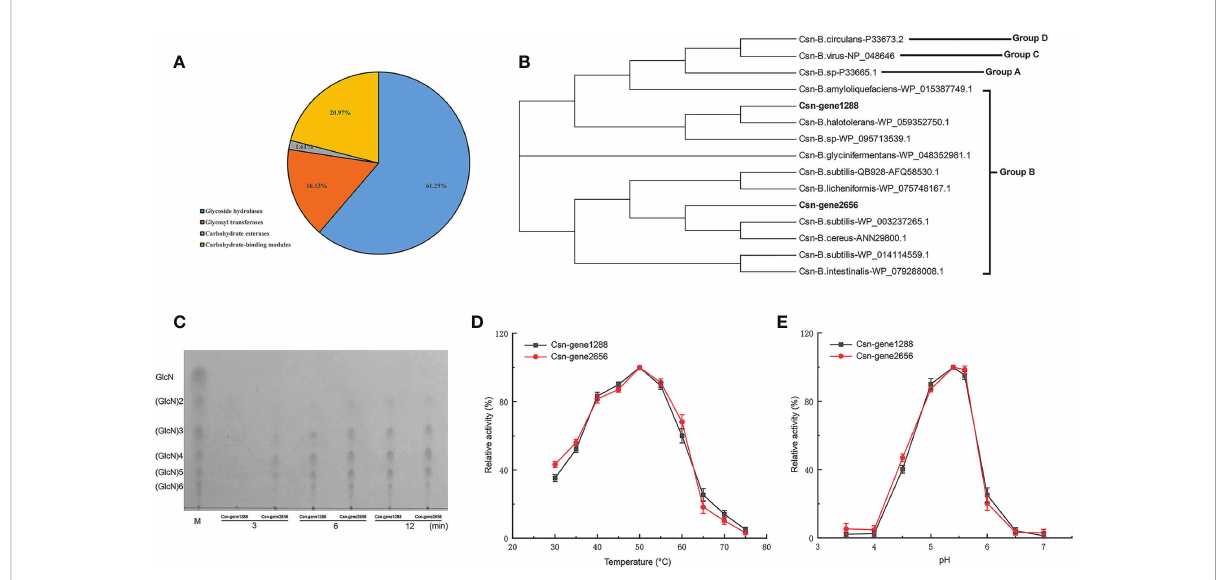
FIGURE 6 Carbohydrate-active enzyme activity analysis of the two chitosanase csn-gene1288 and csn-gene2656. (A) Statistical chart of annotated carbohydrate-active enzyme in B halotolerans LDFZ001. (B) Sequence alignment of csn-gene1288 and csn-gene2656 with that of other GH46 chitosanases. (C) Time course pro fi les of hydrolysis products of csn-gene1288 and csn-gene2656 enzymes on chitosan. (D) Effects of temperature on the enzyme activities of csn-gene1288 and csn-gene2656. (E) Effects of pH on the enzyme activities of csn-gene1288 and csn-